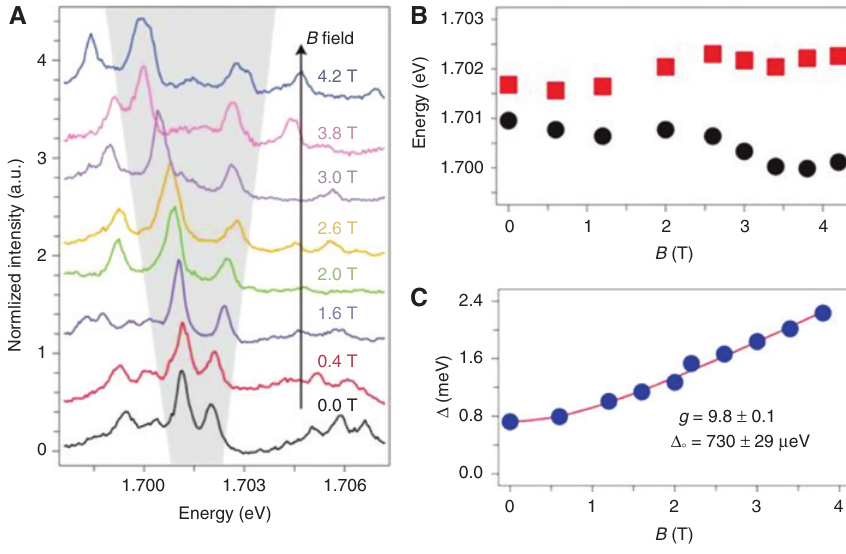
Figure 2: Zeeman effect. (A) Magnetic field dependence of emission spectra from an exemplary quantum emitter in WSe shading identifies the studied emitter. (B) Spectral location of two emission peaks associated with the emitter. (C) Spectral separation of the emission peaks (blue circles) as a function of magnetic field fitted with a hyperbolic function (red curve). Reproduced with permission from Ref. [8], Nature Publishing